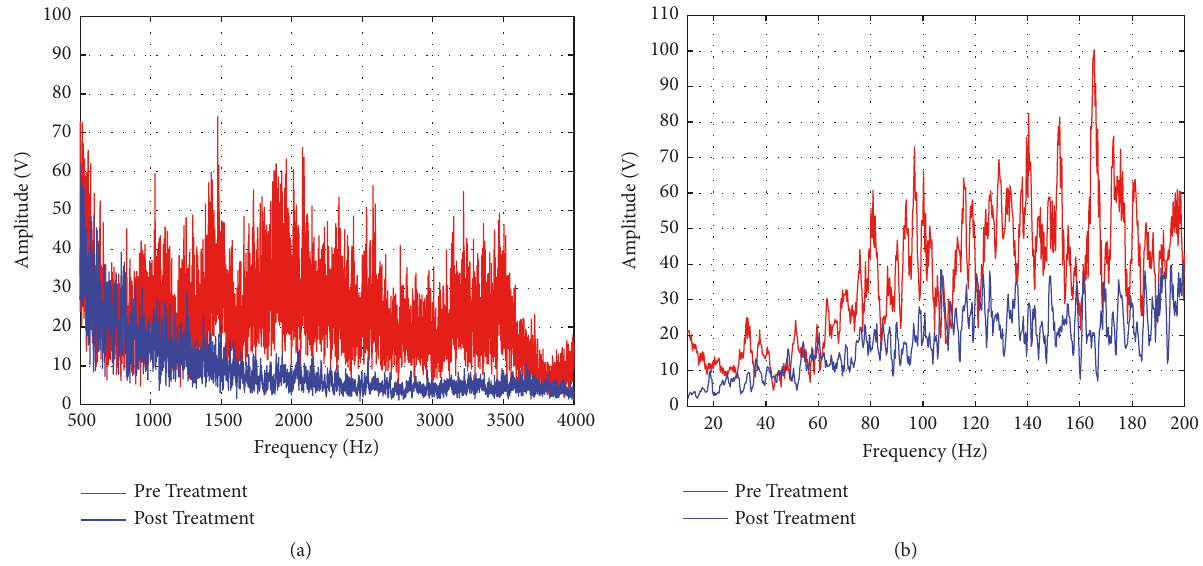
Figure 5: Typical frequency domain data. (a) Representative high frequency domain graph from 500 to 4000Hz showed a decrease in posttreatment amplitudes related to a reduction in soft palate whistling sounds. (b) Representative low frequency domain graph from 0 to 200Hz showed a decrease in posttreatment amplitudes related to a reduction in loudness of snoring sounds and vibrations.